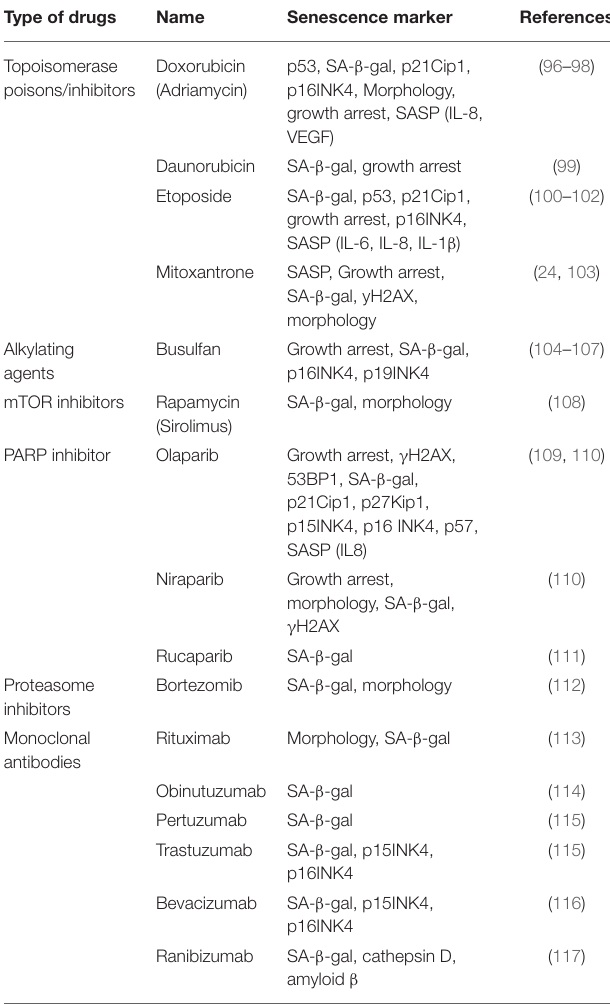
TABLE 1 | FDA approved anti-cancer drugs inducing therapy-induced